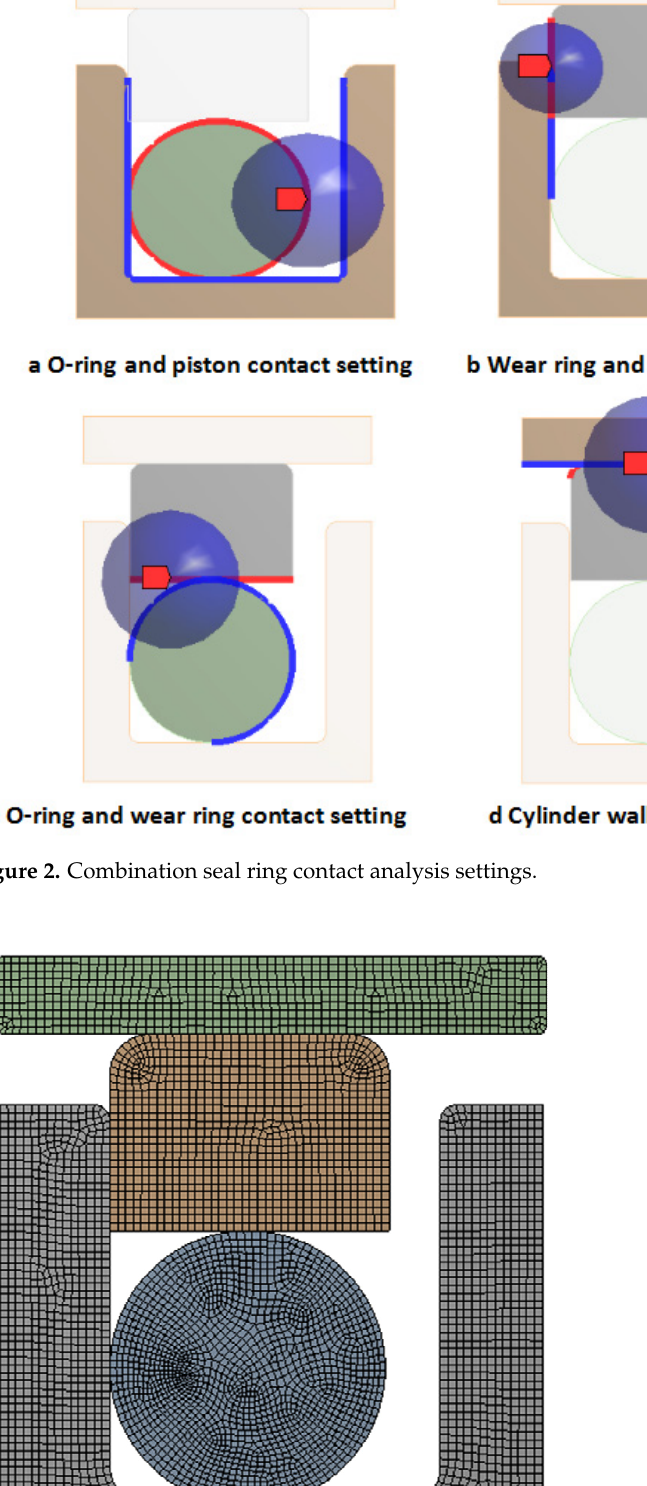
Figure 3. Combined sealing structure grid model.